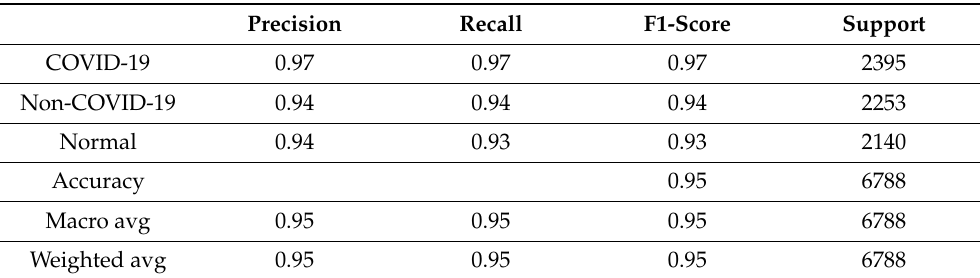
Table 7. InceptionV3 Evaluation results.